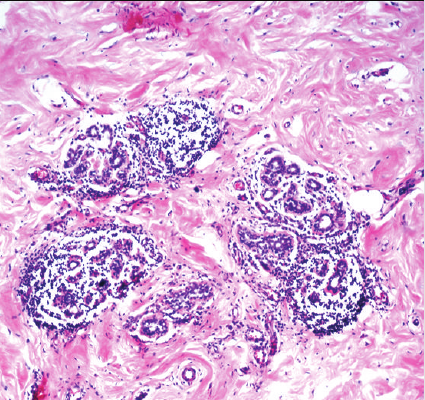
Figure 4: Microscopic images showing interlobular fibrosis with entrapped breast lobules and intralobular lymphocytic infiltration (H/E ×